Question: Identify the chart type used in this figure.
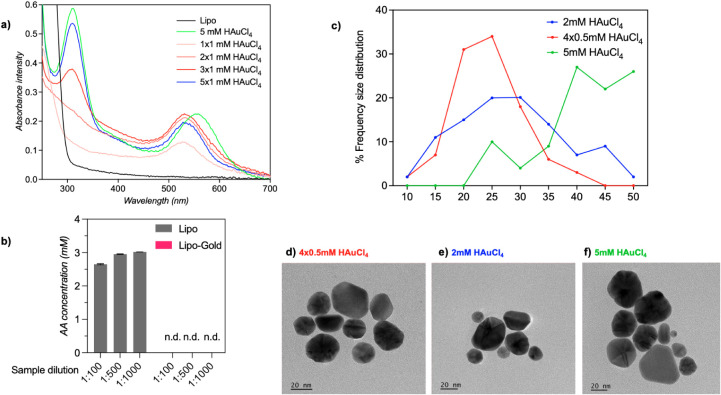
Answer: bar